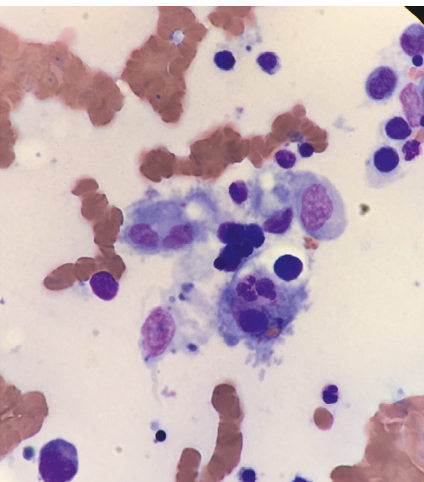
Figure 1: Phagocytosis of hematopoietic cells by macrophages seen in hemophagocytic lymphohistiocytosis (HLH).